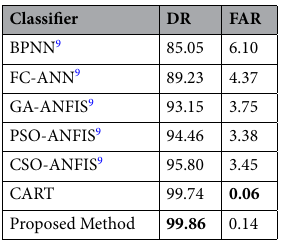
Table 9. Comparison of detection rate and FAR on KDDTrain+ dataset. Significant values are in bold.